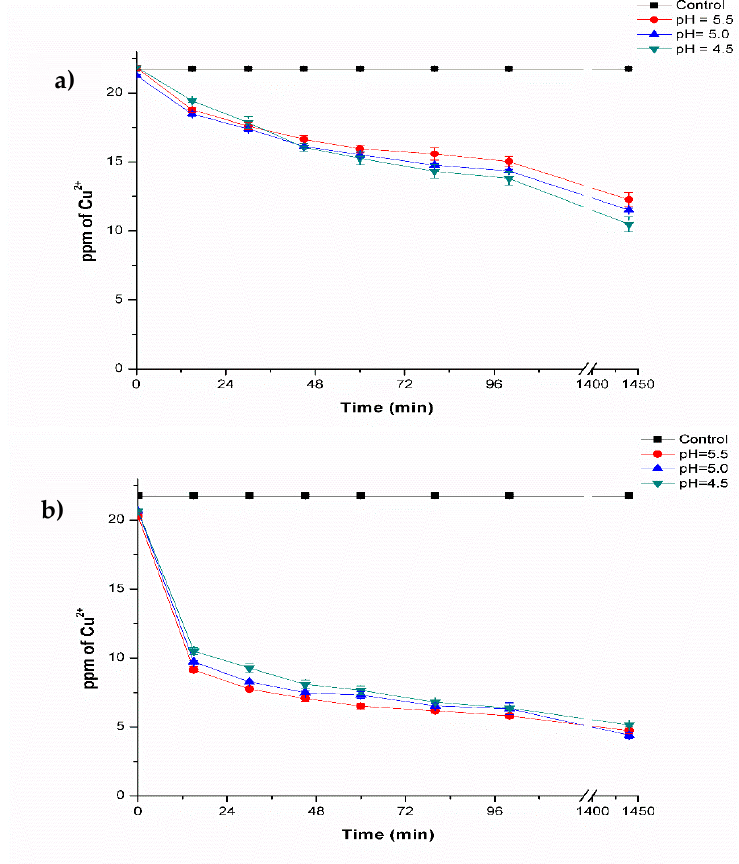
Figure 3. Biosorption of Cu 2+ at 35 °C at different pH values: ( a ) fresh composite beads, and ( b ) lyophilized composite beads. Table 1. Removal of copper using fresh composite beads and lyophilized composite beads at different pH values, at 35 °C.